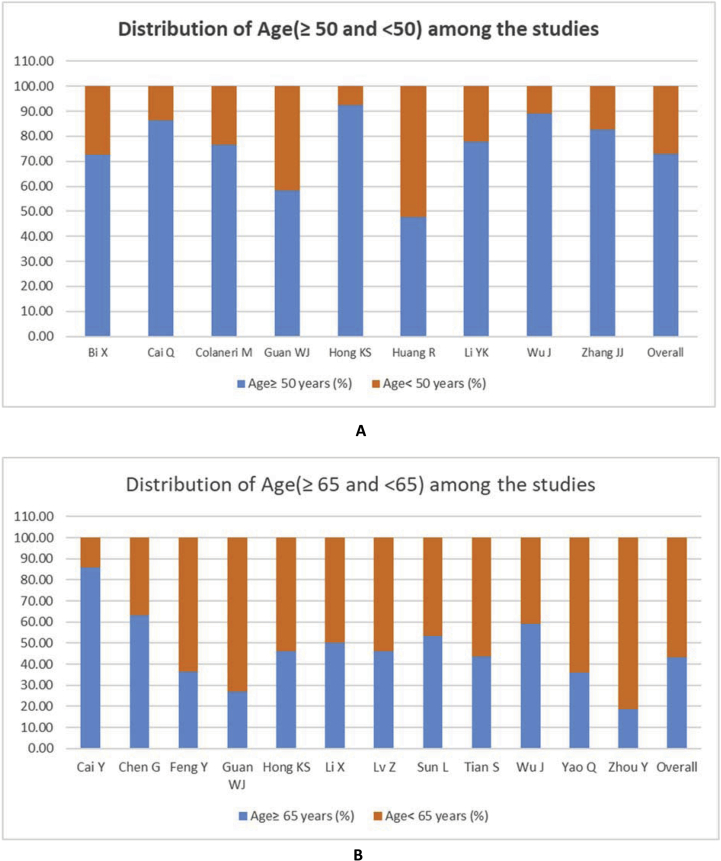
Distribution of age A. ≥ 50 Vs. <50 years and B. ≥ 65 and <65 years among the included studies to analyze the effect of age on for the severity of COVID-19.